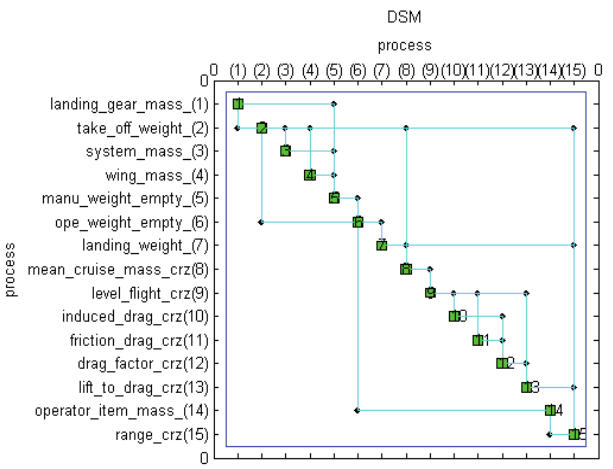
Fig. 10. Results from the computational flow modelling pro- cess. Due to the size of the problem, shown is only the Design Structure Matrix of the Strongly Connected Component with the shortest feedback length.